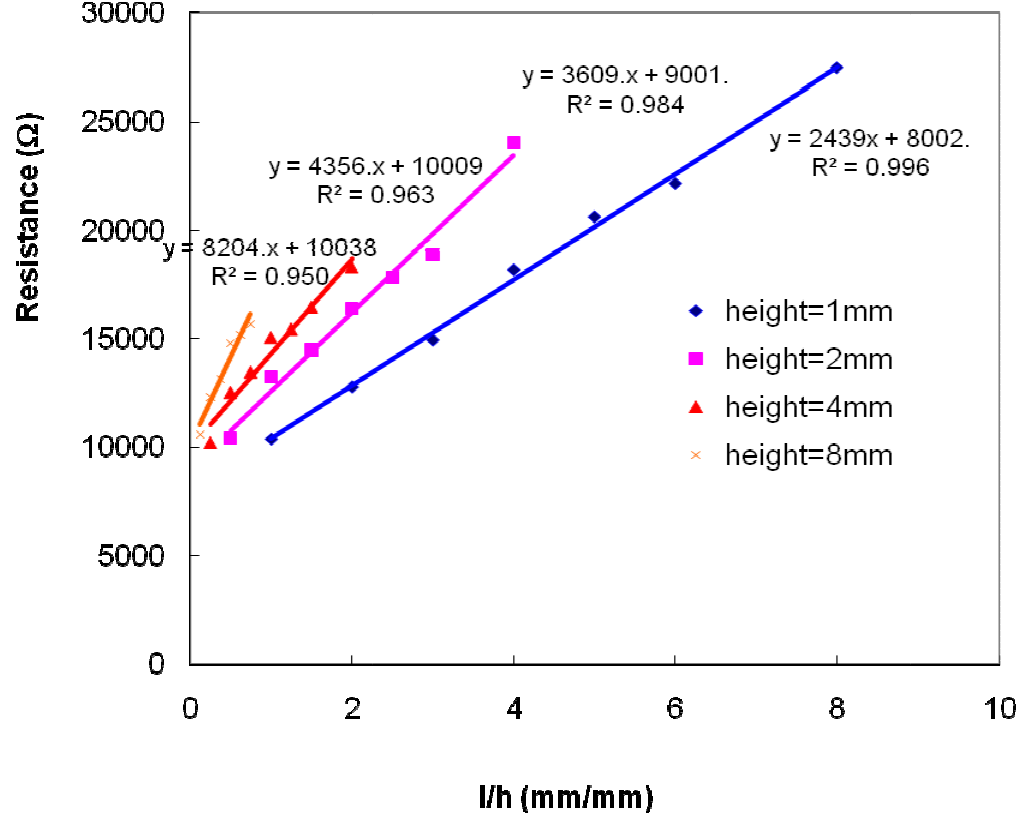
Figure 7. Solution resistances resistance is in linear relationship with l/wh with the slope representing the specific resistivity of the particular solution thickness and it increases with the increase in solution thickness.